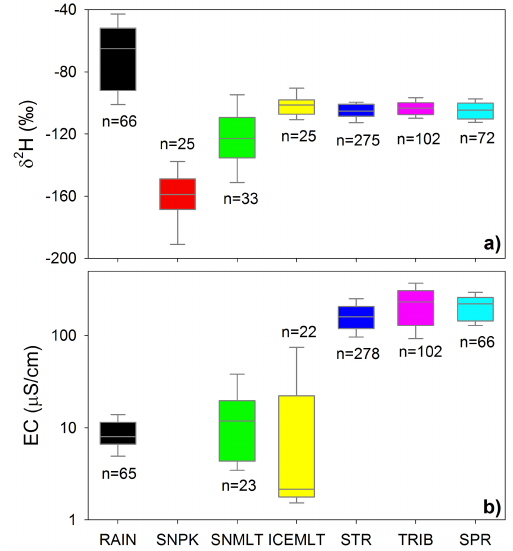
Figure 2. Box-plot for δ 2 H (a) and EC (b) of all water samples col- lected in this study. The whiskers represent the 10th and 90th per- centiles, the box limits indicate the 25th and 75th percentiles and the line within the box marks the median. Legend: RAIN: rain- fall; SNPK: winter snowpack and three samples of fresh snowfall; SNMLT: snowmelt (from patches of old snow and from snowmelt samplers); ICEMLT: ice melt (glacier melt and debris-covered ice); STR: main stream; TRIB: tributaries; SPR: springs. EC data of the snowpack (SNPK) were not